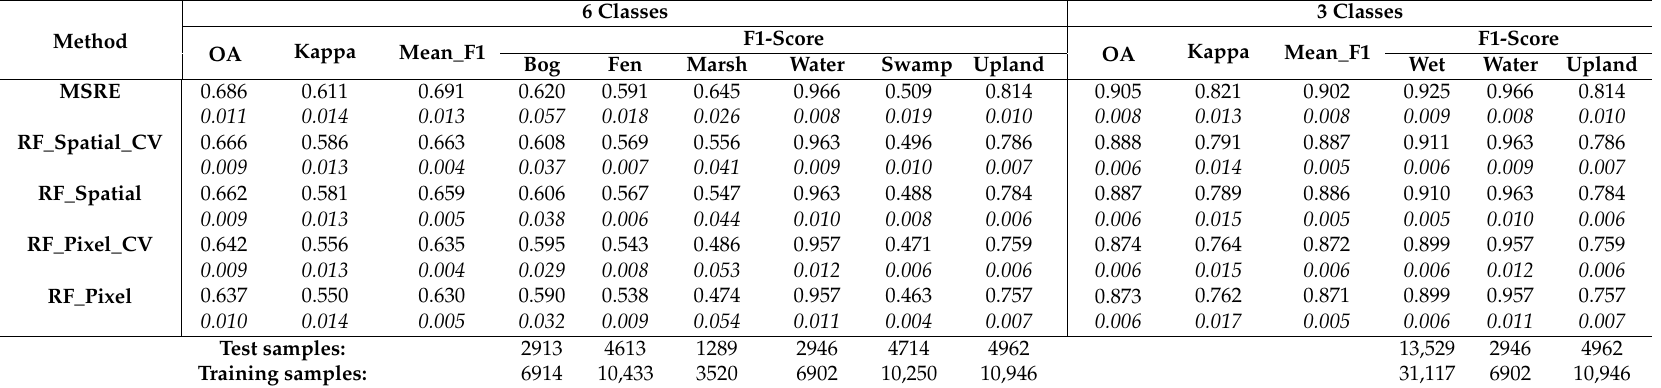
Table 3. ABMI_PP results including May and October composites for region sampling of photo-plots and hold-out training convergence. 6 Classes 3 Classes